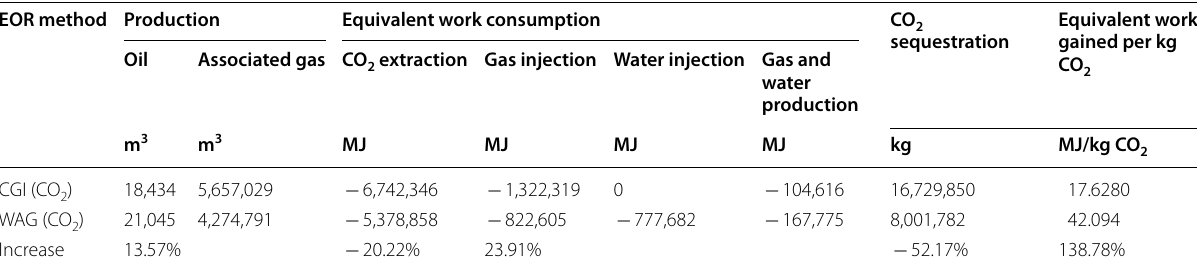
‑EOR simulation for the typical reservoir model 2